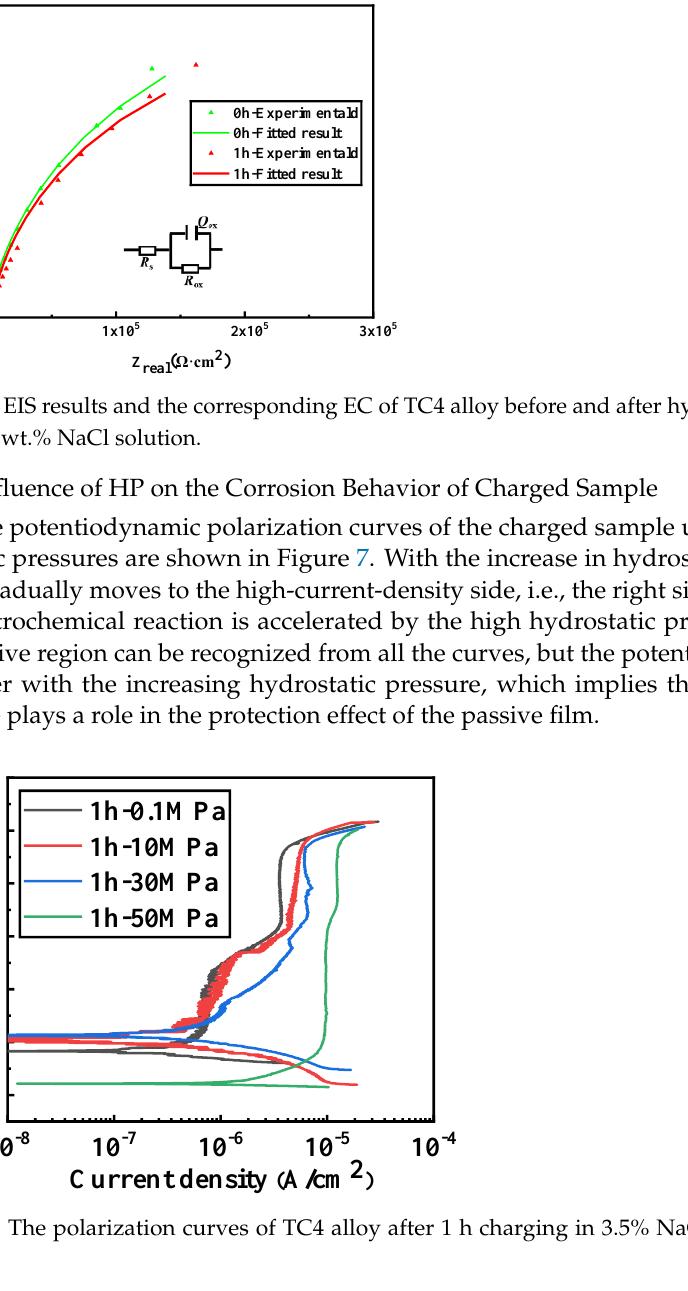
Figure 5. Potentiodynamic polarization curves of TC4 alloy before and after hydrogen charging for 1 h in 3.5 wt.% NaCl solution.